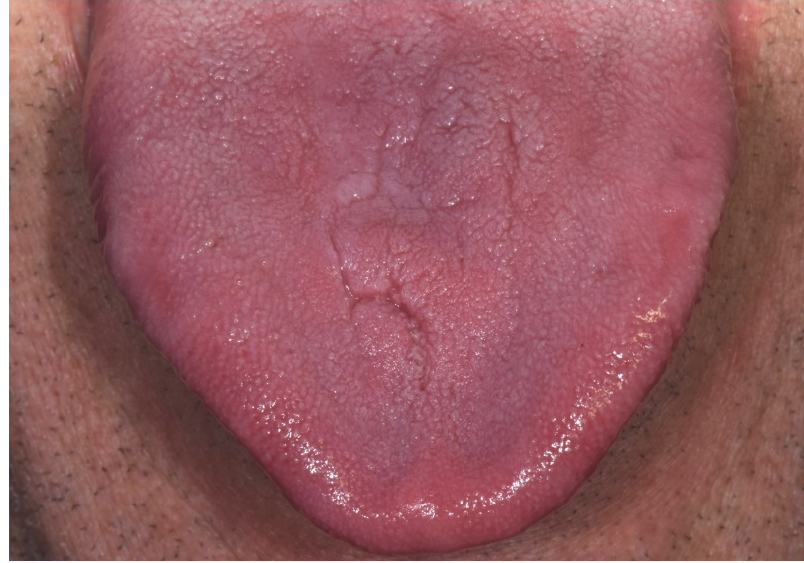
Figure 2. Complete resolution of the lesion at six weeks, after incisional biopsy with pus drainage and one-week antibiotic therapy.